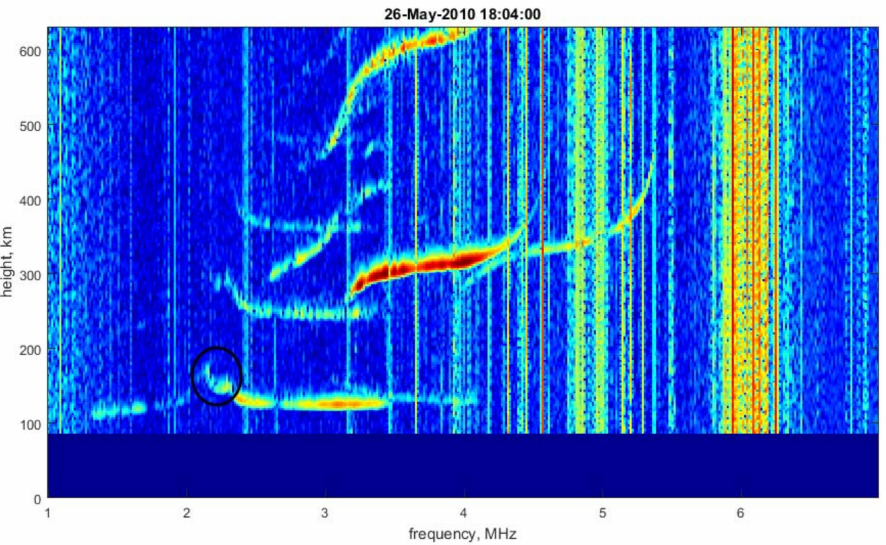
Figure 2. An example of the ionogram containing an E s layer with a double cusp in the low-frequency part of the trace at 18:04:00 LT on 26 May